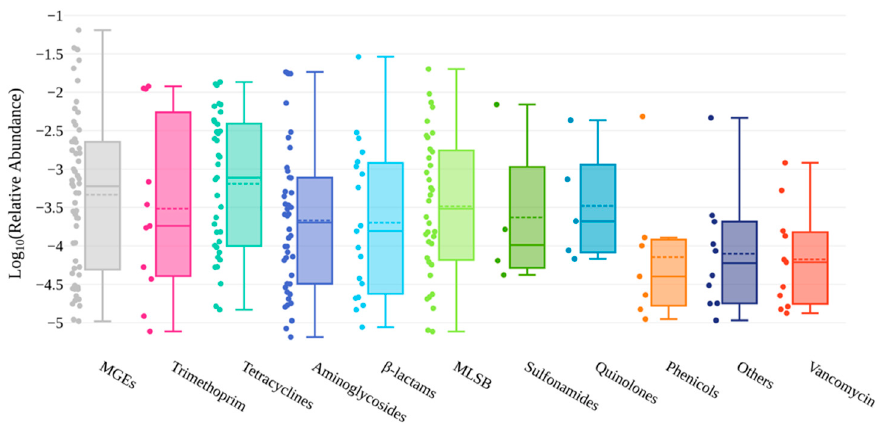
Figure 3. The mean of the relative gene abundances (log 10 transformed values) for each ARG class and MGEs (including the integrons) detected in the red fox samples under study are represented on the box plot, where error bars represent standard deviation.